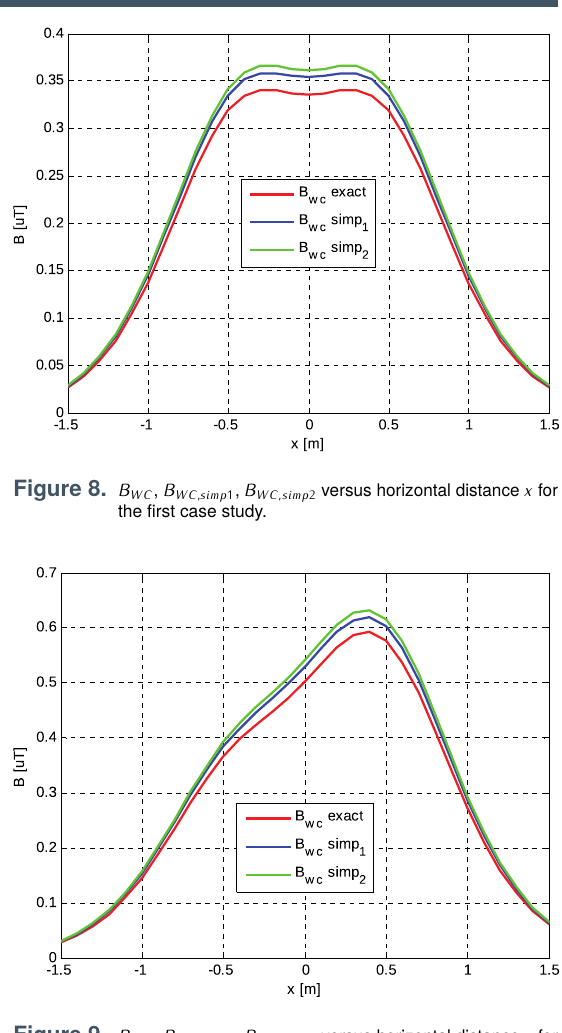
relevant numerical values and percent errors of B and B with respect to B WC,simp 2